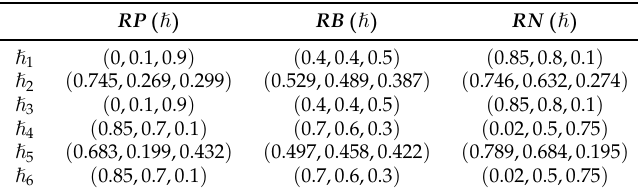
(cid:18) b · | (cid:98) N β (cid:101) E ( (cid:125)